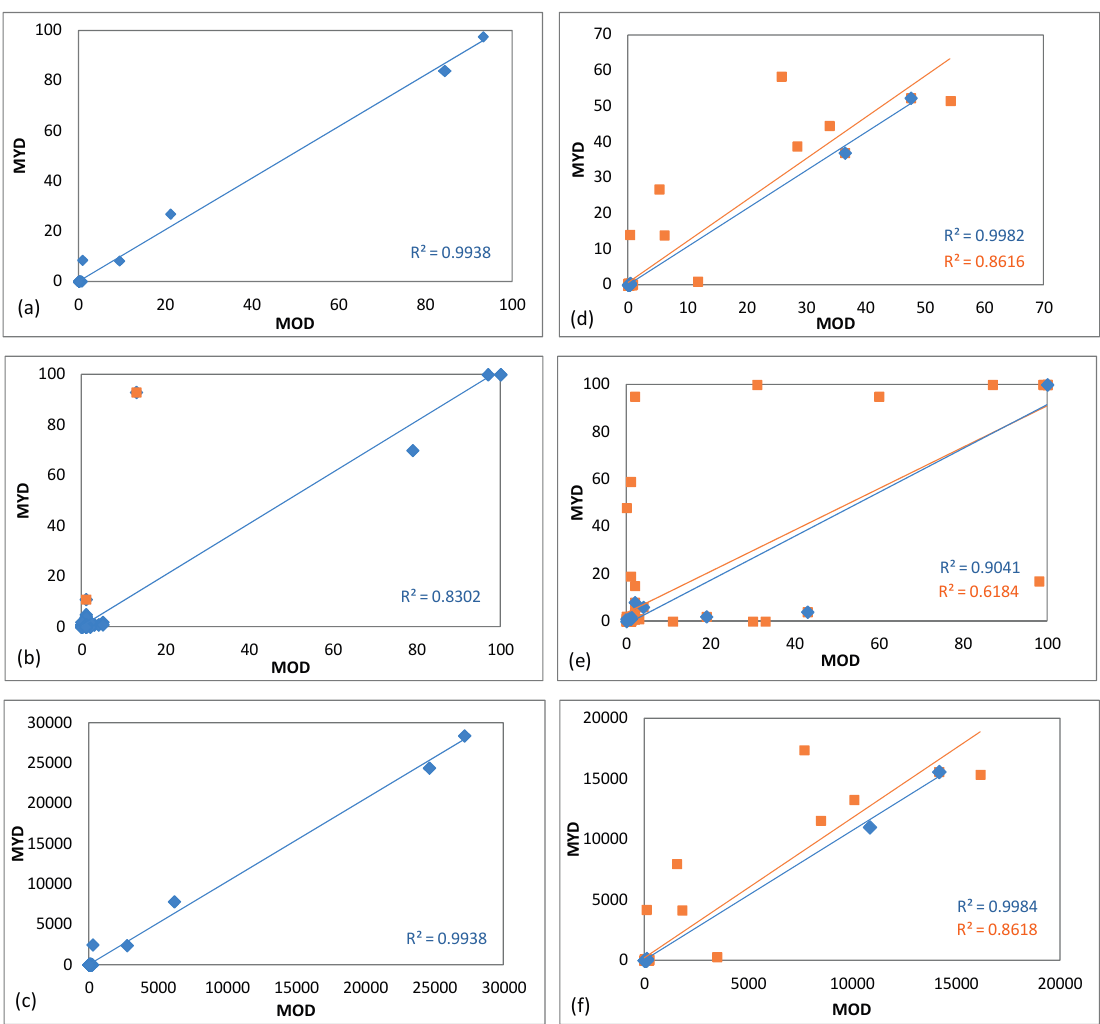
Figure 10. Mean ( a ), Maximum ( b ) and Total ( c ) OWL value for MYD verses MOD flood extent for the dates in common for Site W1. Mean ( d ), Maximum ( e ) and Total ( f ) OWL value for MYD verses MOD flood extent for the dates in common for Site W2. (Orange shows the points with a large difference in range distance between the MOD and MYD images).